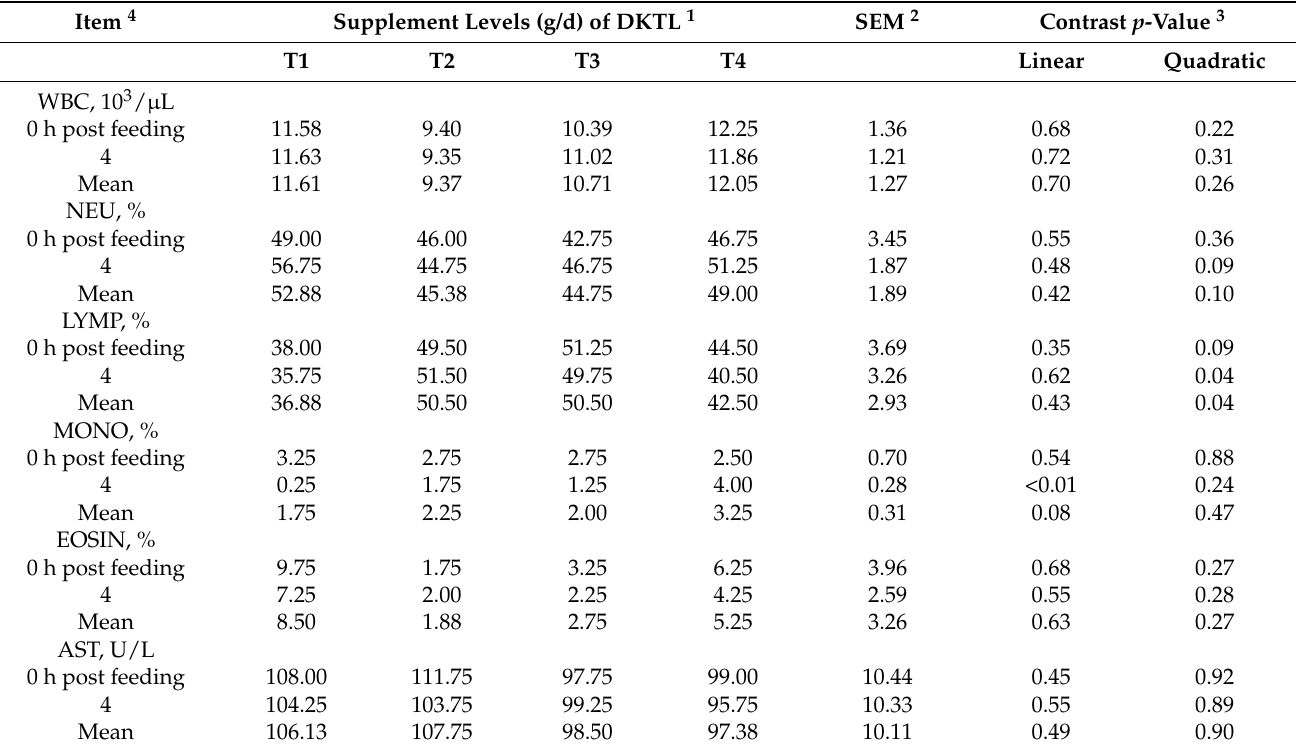
Table 8. Effects of supplement levels (g/d) of dried kratom leaves on white blood cell and liver function in